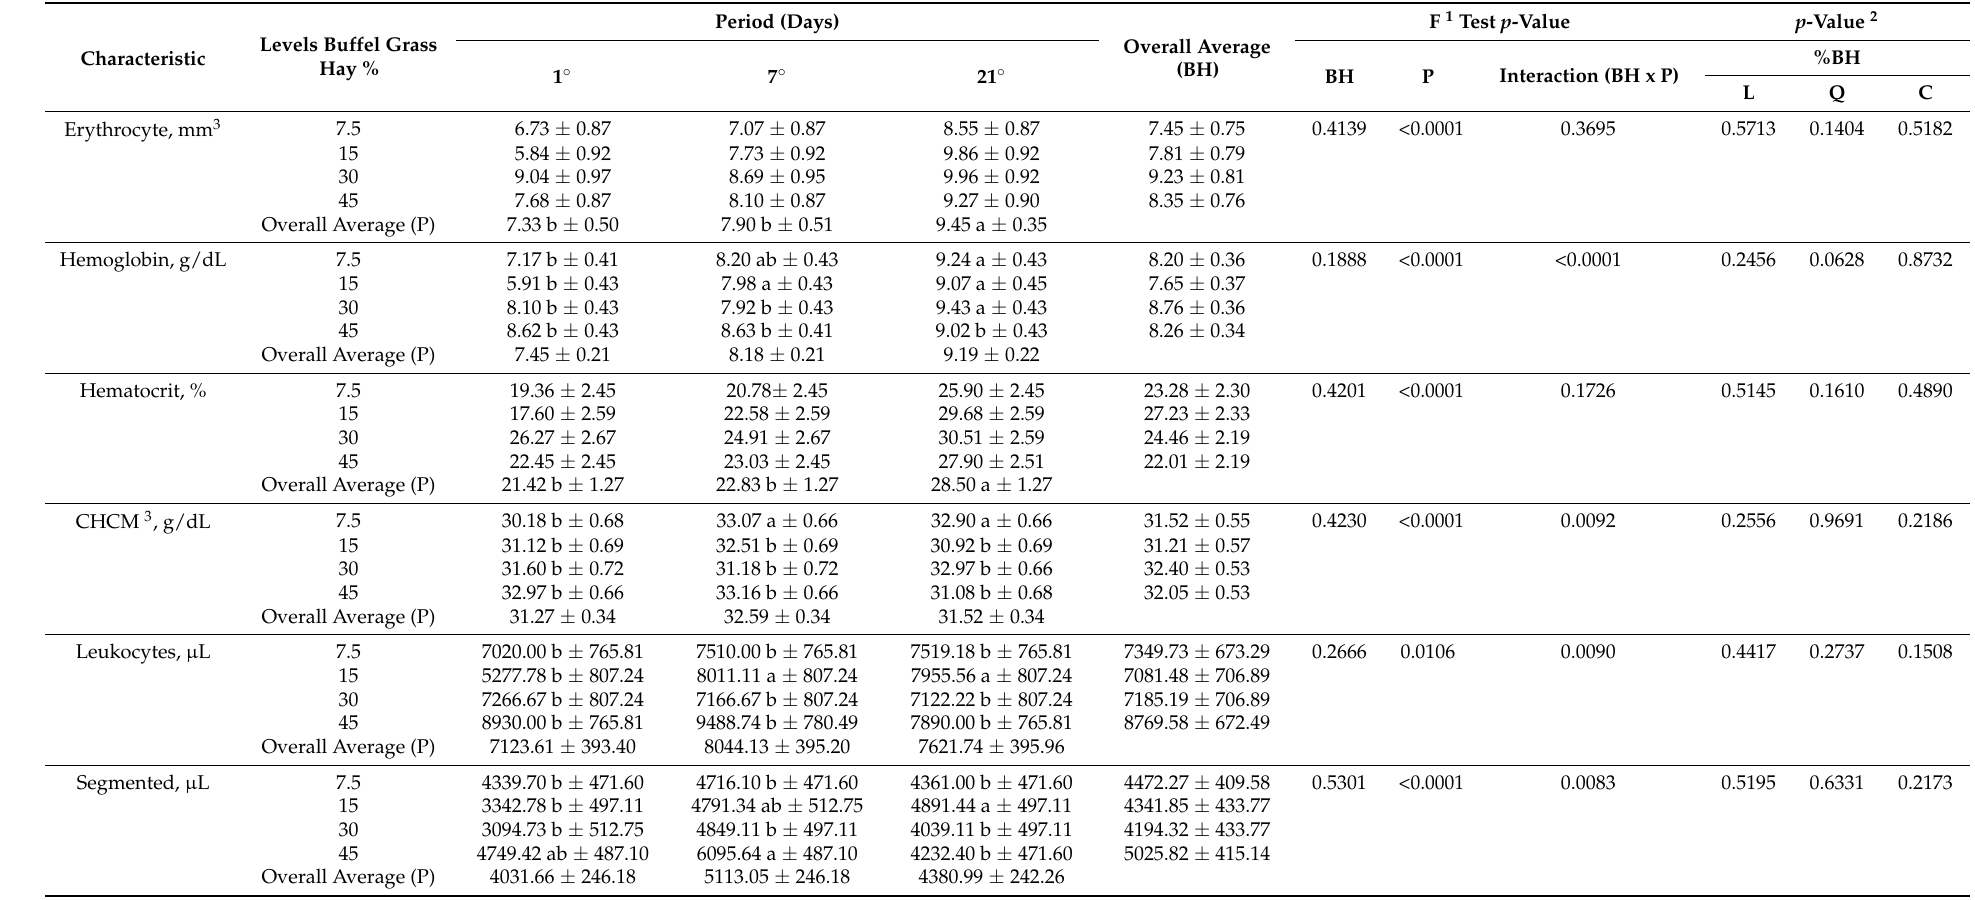
Table 6. Blood parameters of sheep fed levels of buffel grass hay and cactus